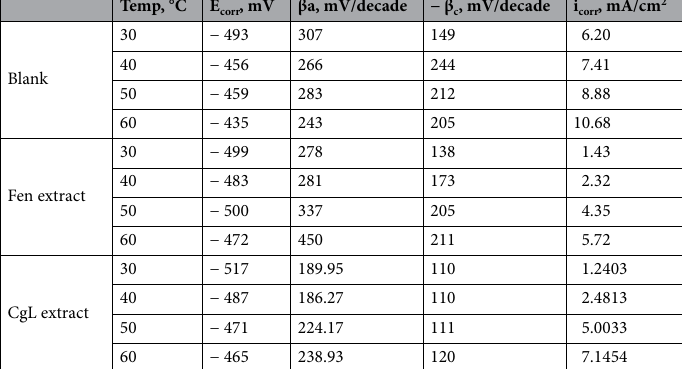
Table 5. Electrochemical polarization parameters of steel in 20% phosphoric acid in the absence and presence of 0.8 g/L Fen and 0.4 g/L CgL extract at different